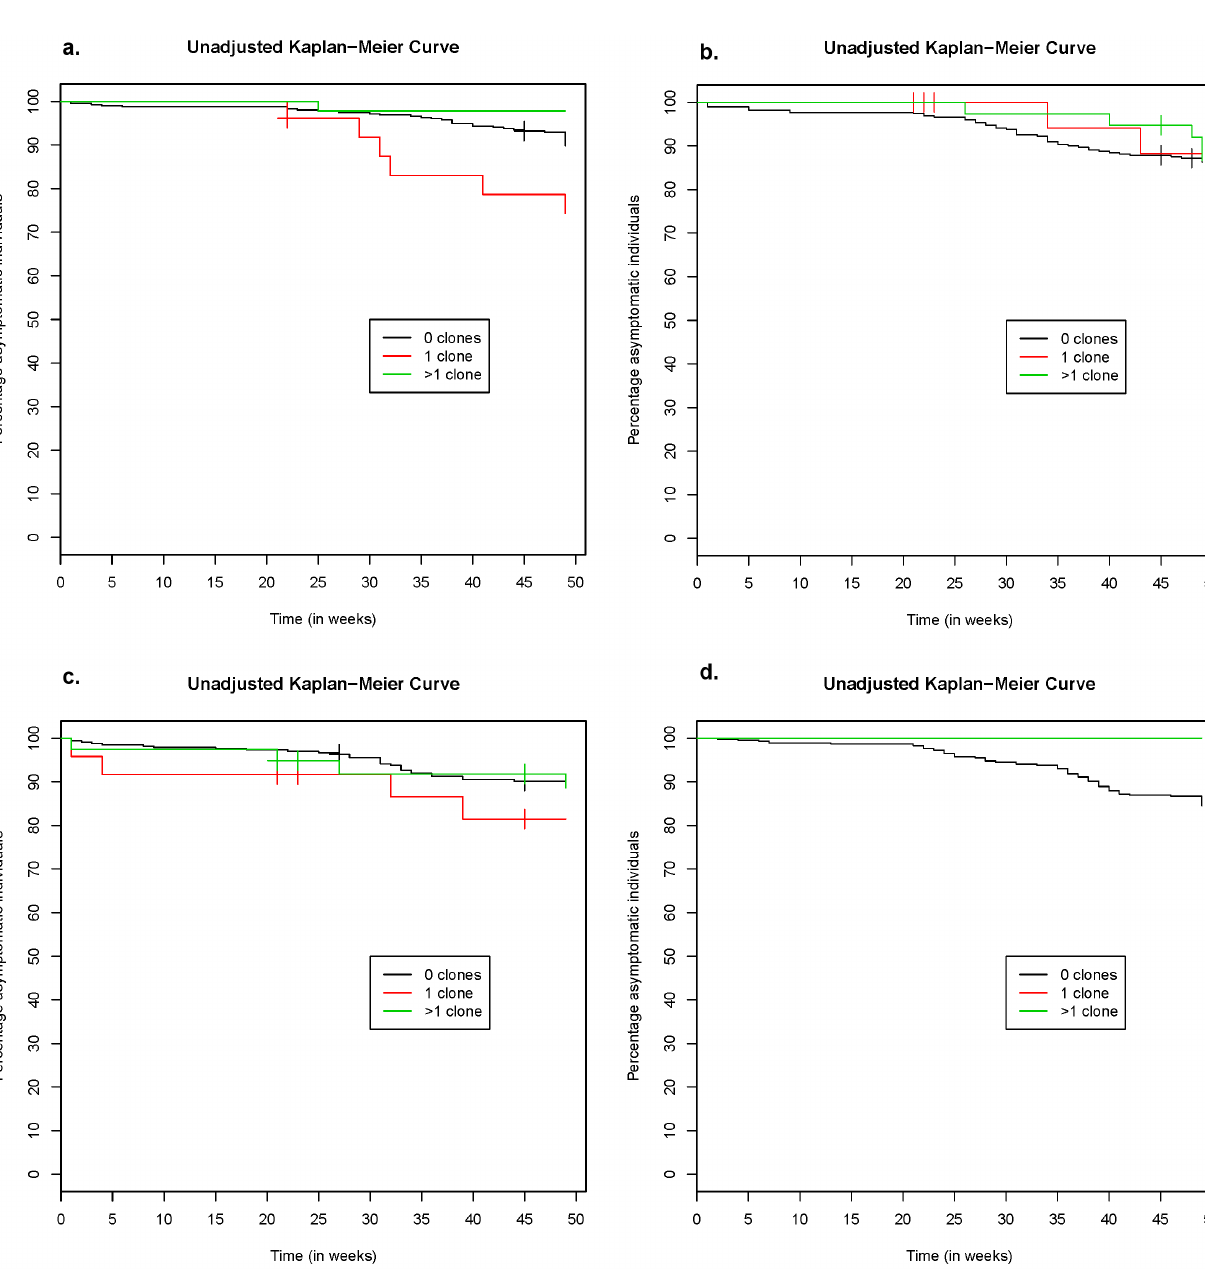
Figure 4. Kaplan Meier estimate (unadjusted) of time to subsequent clinical episode (fever and any P. falciparum ) in 1856 asymptomatic children; a) placebo, b) SP bimonthly c) AS + AQ bimonthly and d) AS + AQ monthly. In the AS + AQ monthly group no children with parasites at the survey after ended intervention developed clinical malaria.